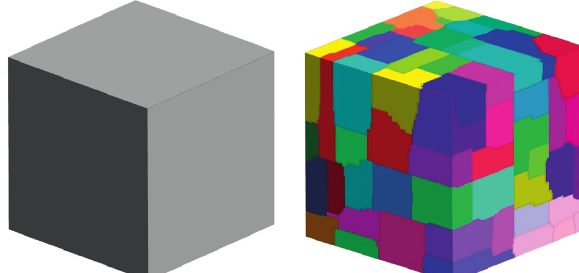
Figure 9: The box model and domain decomposition into 95 partitions (different color represents different